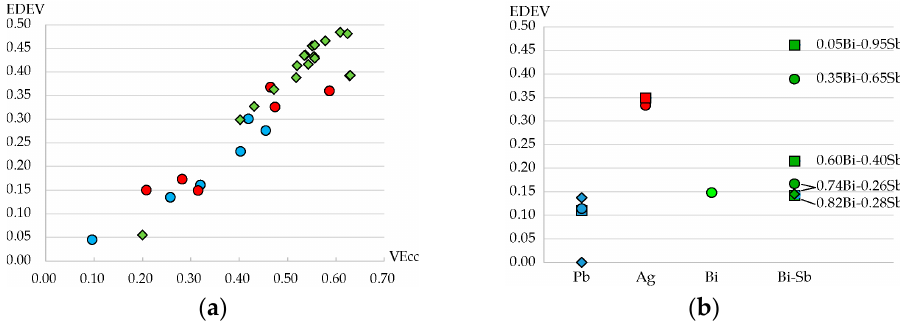
Figure 10. ( a ): Correlation between 𝐸𝐷𝐸𝑉 (cid:3025) and ´volume-based´ eccentricity — 𝑉𝐸𝑐𝑐 in andorite VI (´senandorite´) (Topa, personal communication); ( b ) 𝐸𝐷𝐸𝑉 (cid:3025) values for Pb, Ag, Bi, and Bi–Sb poly- hedra in Sb–rich gustavite (Pažout and Dušek [37]) (circles), terrywallaceite (Yang et al. [38]) (squares), and Sb–rich vikingite (Pažout and Dušek [39]) (diamonds). The polyhedra with mixed central positions, display progressively higher 𝐸𝐷𝐸𝑉 (cid:3025) with higher Sb content. Blue points repre- sent Pb, red points — Ag, light − green points — Bi or Sb, and dark − green points — mixed Bi-Sb. Bi–sulfosalts have lower distortions in semimetal polyhedra and therefore, the reci- procity between 𝐸𝐷𝐸𝑉 (cid:3025) and other quantities expressing the internal distortion develop at much lower values (Figure 11). Synthetic cannizzarite (Matzat [36]) shows a narrow range of 𝐸𝐷𝐸𝑉 (cid:3025) which barely reaches values of 0.3. The two branches visible in the dis- tribution of Bi in Figure 11a correspond to the H (PbS) and Q (SnS) layers in the crystal structure. A separation also exists between the Pb polyhedra: the ones in the Q layers (mostly mono-or bicapped trigonal prisms) show higher distortion than those in the H layers (octahedra), with the latter narrowly exceeding values of 0.05 𝐸𝐷𝐸𝑉 (cid:3025) .